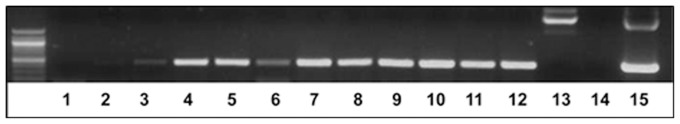
DNA amplification of the Hg-unc78 from metagenomic DNA samples.Lanes 1–3, metagenomic DNA including 1 SCN J2; Lanes 4–6, metagenomic DNA including 10 SCN J2; Lanes 7–9, metagenomic DNA including 100 SCN J2; Lanes 10–12, metagenomic DNA including 1,000 SCN J2; Lane 13, cloned gene without primers (control); Lane 14, without DNA (control); Lane 15, positive control, amplification product is Hg-unc 78 amplified from the cloned gene.